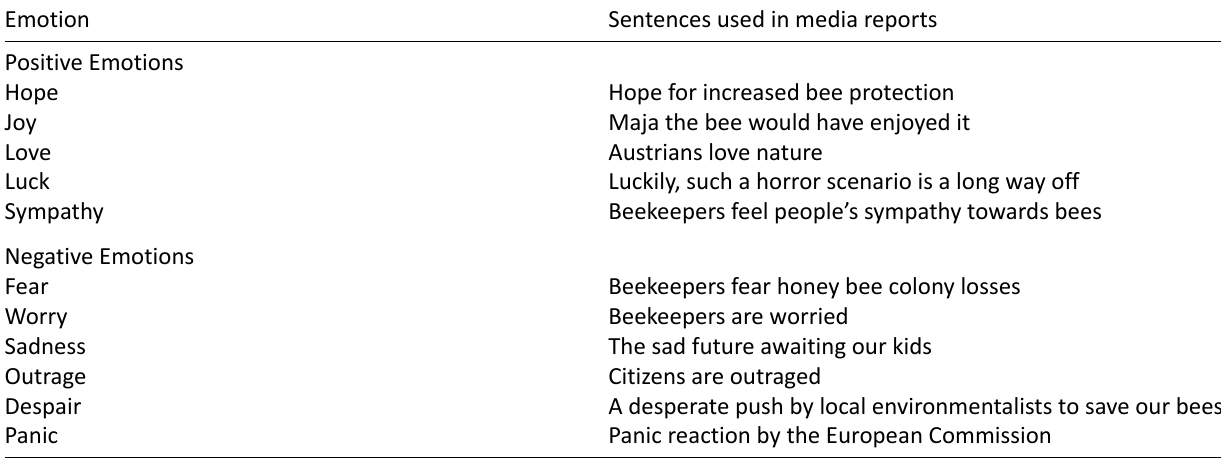
Table 2. Examples of how journalists incorporated positive and negative emotions in news stories. Emotion